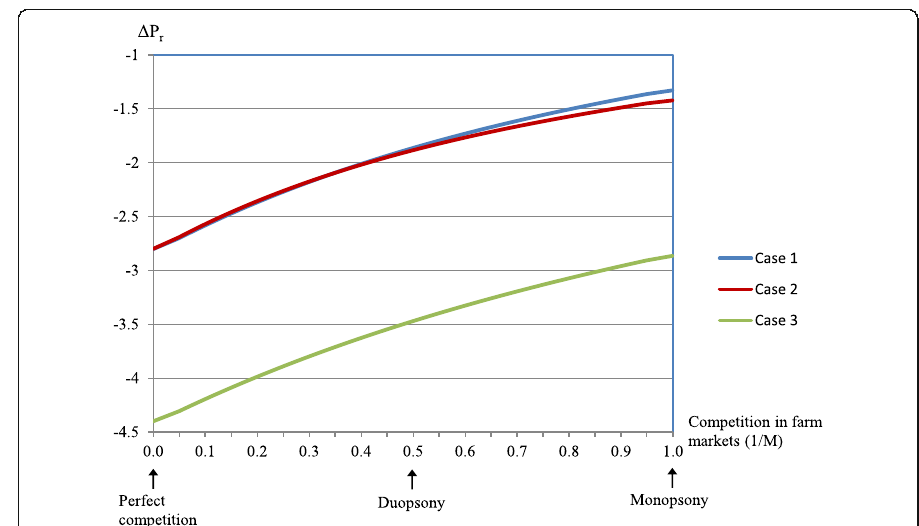
Fig. 3 Retail price decrease ( Δ P r ) due to the weakened seller power in food retailing under various levels of buyer power in farm markets. Note: Δ P r is the decrease in retail price when retailers ’ seller power is weakened from N =2 to N =3. The magnitude of decrease (| Δ P r |) is smaller when the processors have stronger buyer power in farm markets. Case 1 is when there is a competitive wholesale market. Case 2 is when there is an oligopoly wholesale market. Case 3 is when there is an oligopsony wholesale market. Retail price decrease (| Δ P r |) in case 3 (green line) is larger than that in case 1 (blue line). The relative magnitudes between retail price decrease in case 2 and those in cases 1 and 3 depend on various market factors so that all (in)equalities between them are possible